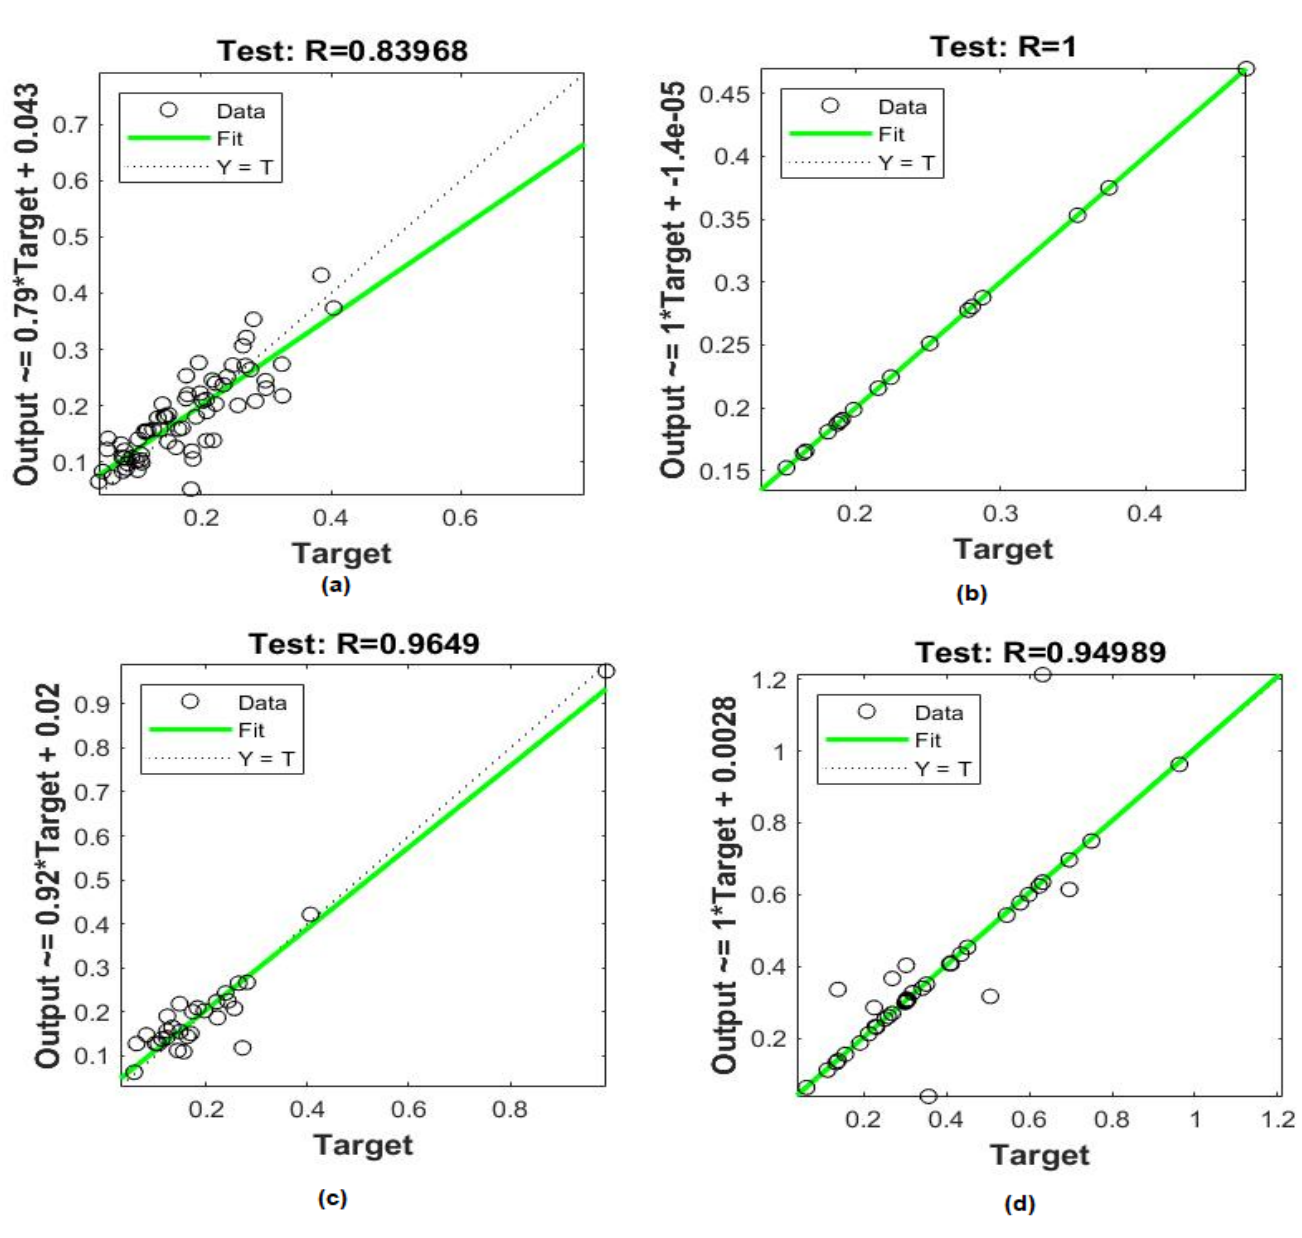
Figure 8. Regression plot of the ANN model for predicting house prices at the testing phase: ( a ) Riyadh, ( b ) Dammam, ( c) Jeddah, and ( d ) Al-Khobar.